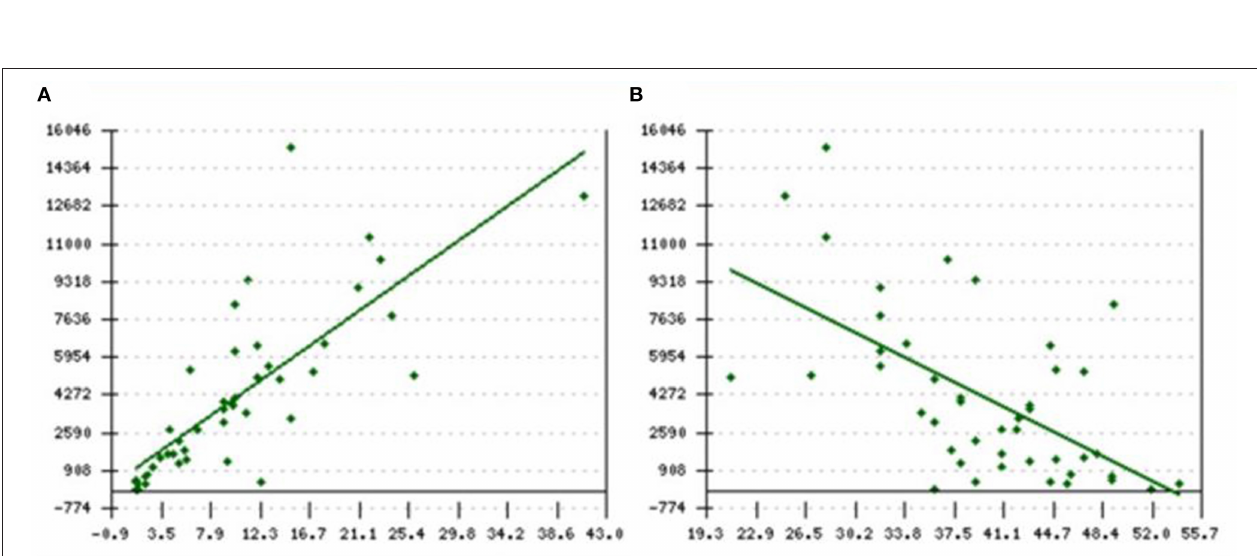
FIGURE 4 | (A,B) Pearson’s correlation between current (A) SF and Liver T2*MRI (positive) r = 0.78; p < 0.001 as well as (B) SF and Cardiac T2*MRI (negative) r = − 0.6; p < 0.001. X-axis represents final/current LIC levels whereas SF and T2* are represented on Y-axis in (A,B) , respectively. SF, serum ferritin; LIC, liver iron